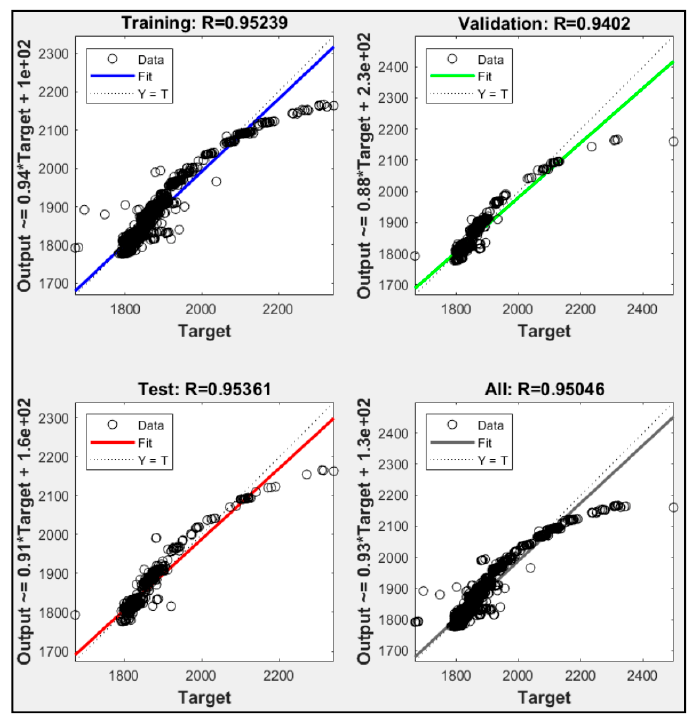
Figure 8. Regression result of P3.